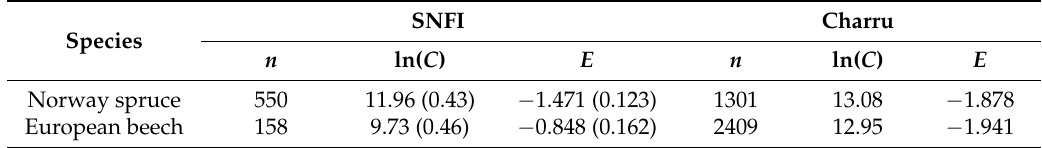
Table 3. Coefficients of the self-thinning rule estimated using quantile regression ( τ = 0.95) with the NFI data and coefficients found by Charru et al. [43] using stochastic frontier analysis.